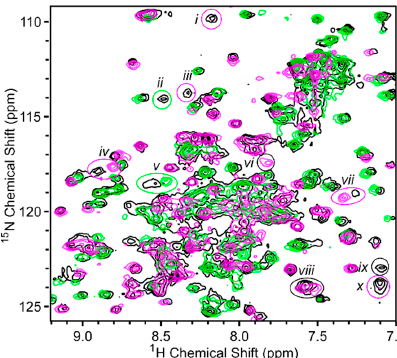
Figure A3. The expanded region of 1 H, 15 N-HSQC spectra of in vivo-associated 15 N-labeled Scc4:His 6 -Scc1 (black), renatured 15 N-Scc4:His 6 -Scc1 (pink), and renatured Scc4: 15 N-His 6 -Scc1 (green) overlaid to highlight minor differences in the spectra. The region shown is the same as in Figure 7B. Minor peak differences between the spectra are indicated with circles labeled i-x. Pink and green circles indicate the assignment of the peak to the Scc4 or His 6 -Scc1 chain, respectively. Black circles show peaks unique to either the in vivo-associated or renatured complex spectrum.